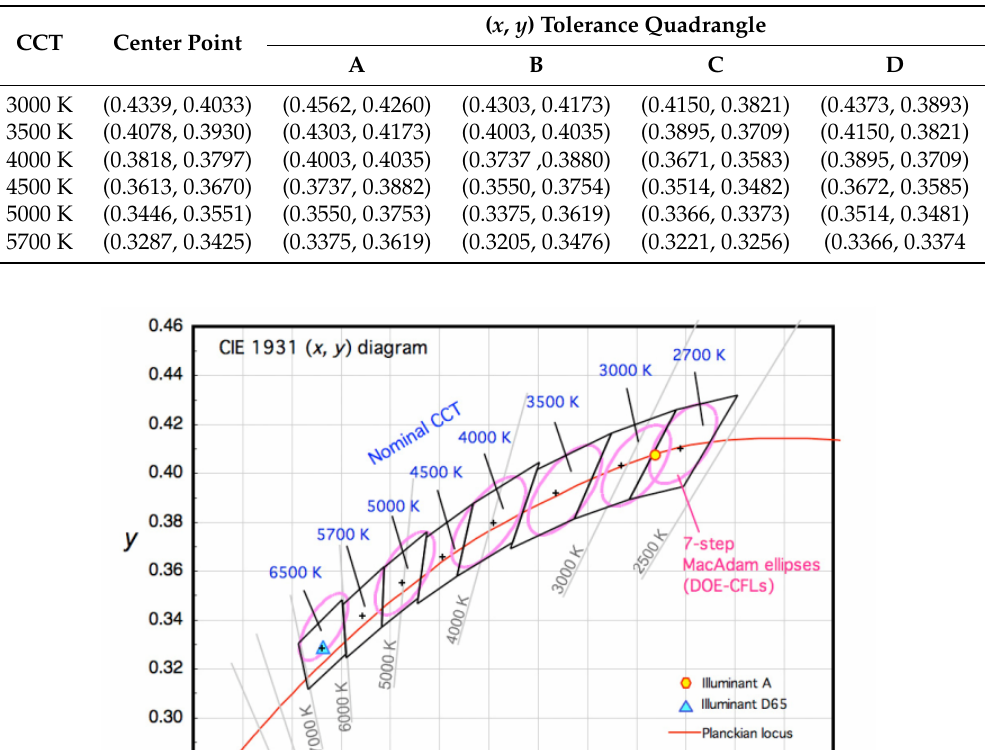
Table 1. Coordinate of four corners for quadrangle chromaticity constraint under different correlated color temperatures (CCTs).